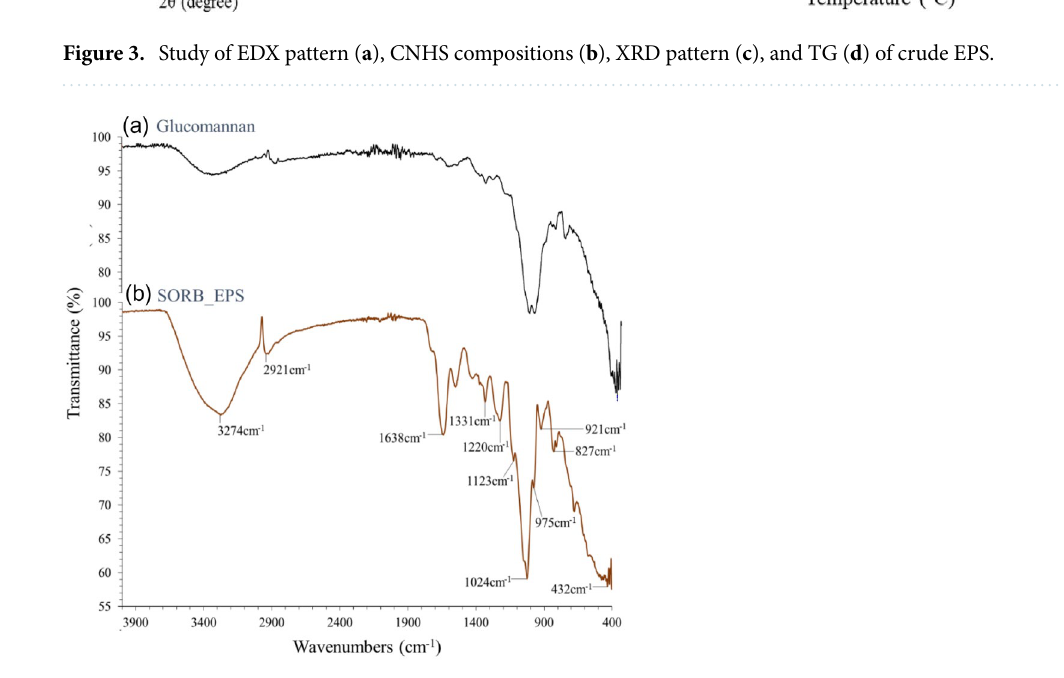
Figure 4. FT-IR spectra of standard glucomannan ( a ) and crude SORB-EPS ( b